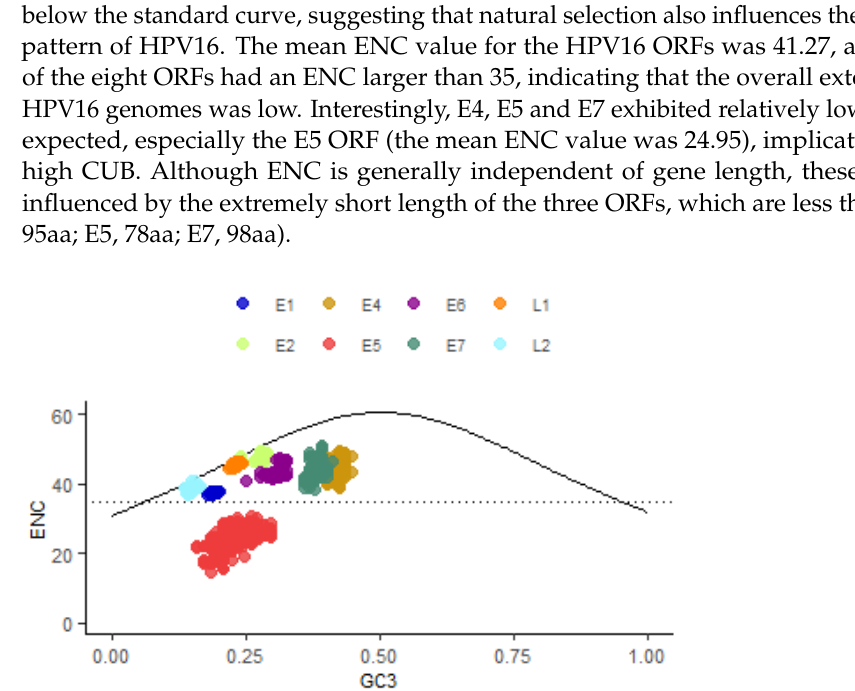
Figure 3. ENC plot of the eight ORFs of HPV16. The continuous curve plots the relationship between GC3 and ENC in the absence of selection. The horizontal dotted line represents the ENC value of 35. Almost all points lie below the curve.